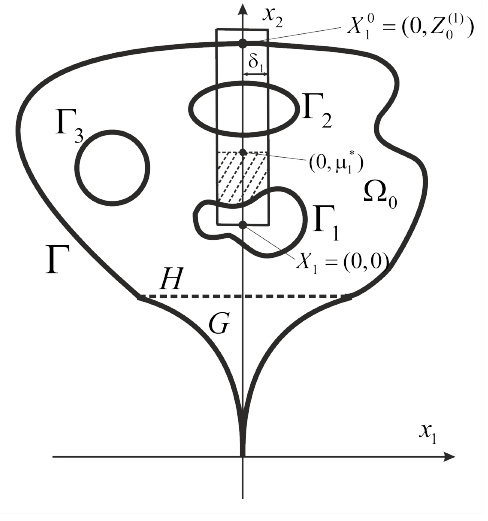
Figure 2. The strip Υ ( 1 ) . Dashed area is (cid:101) Υ ( 1 )